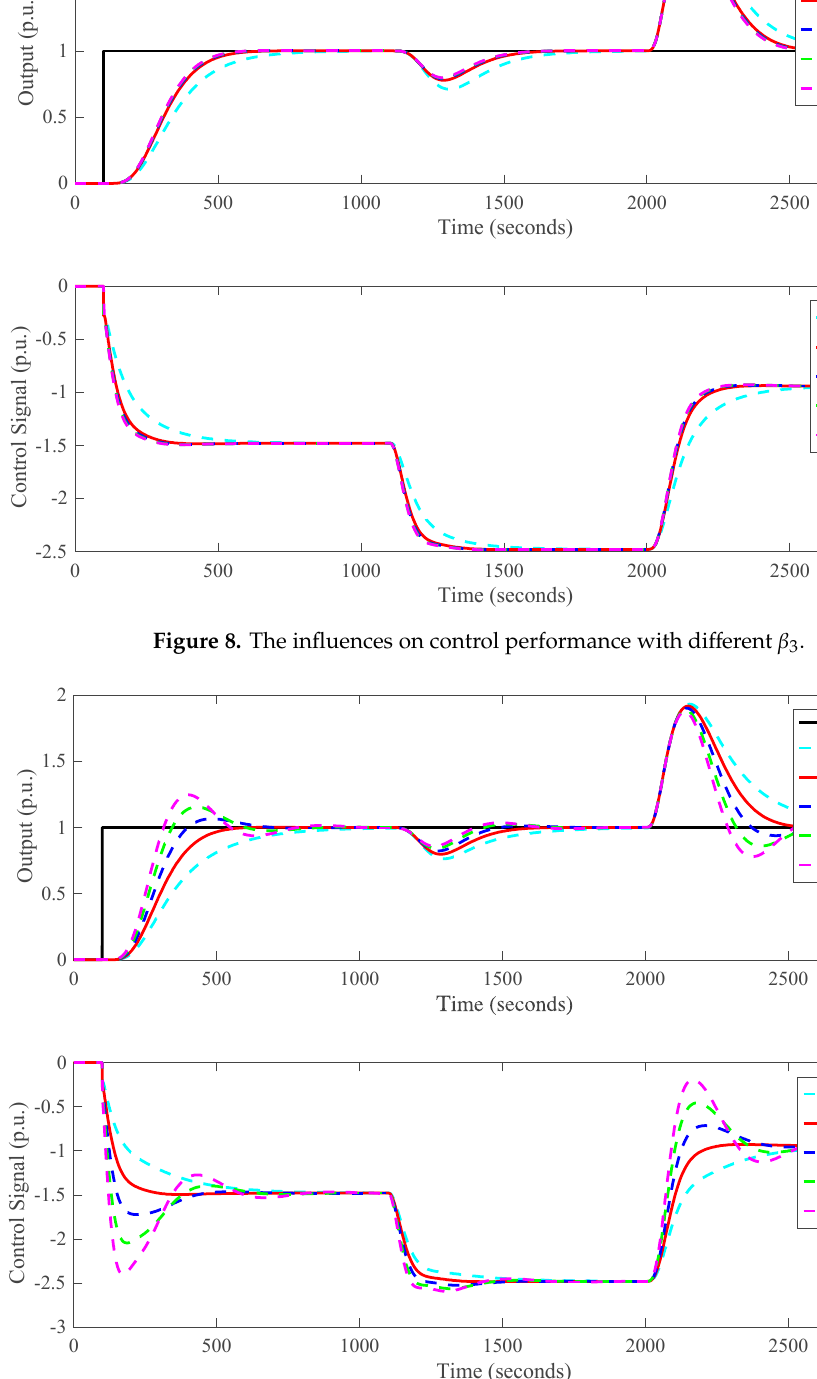
Figure 9. The influences on control performance with different ω c .